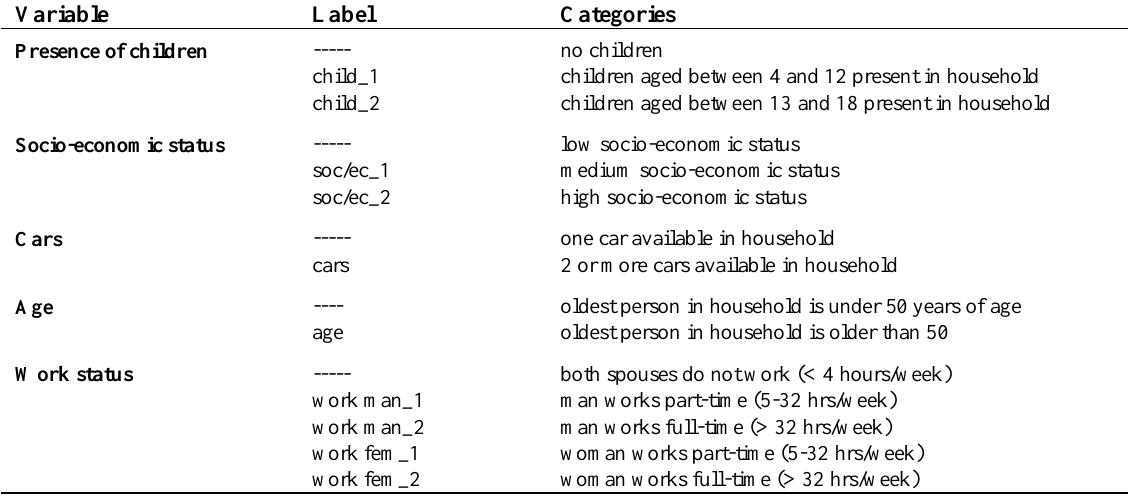
Table 1. Categorisation of independent variables